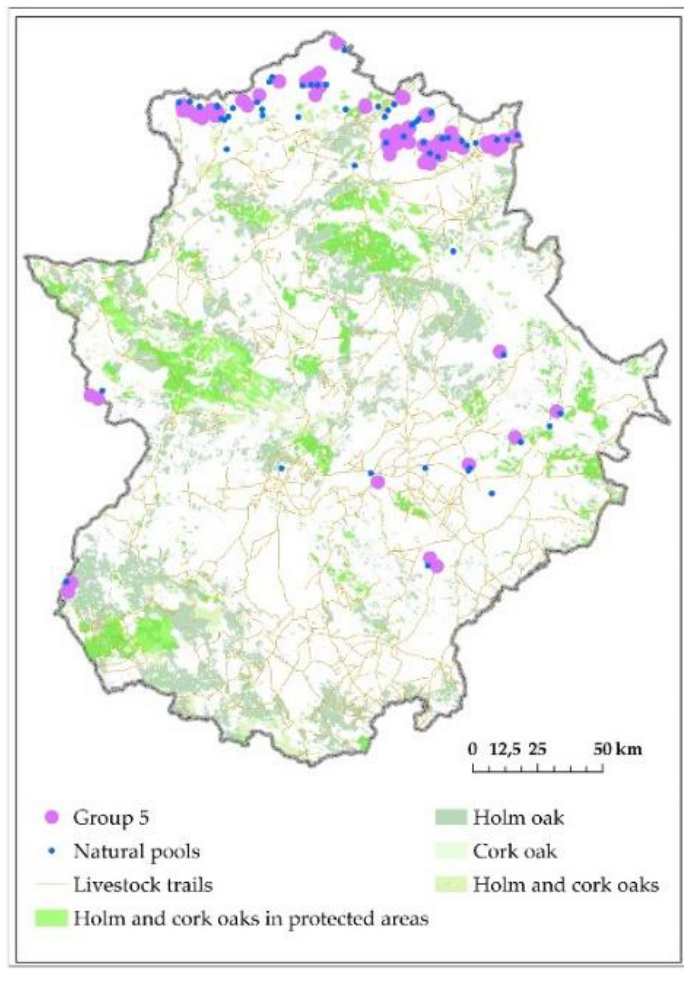
Figure 11. Group 5.